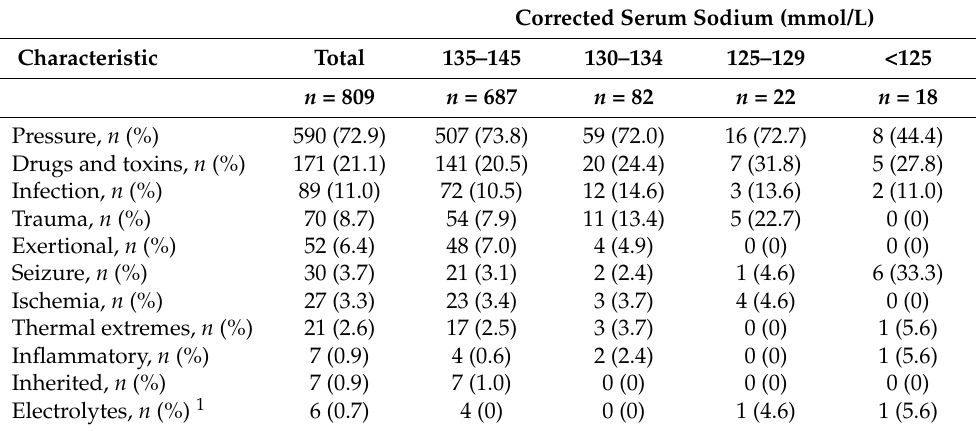
Table 4. Mechanisms of rhabdomyolysis grouped by serum sodium